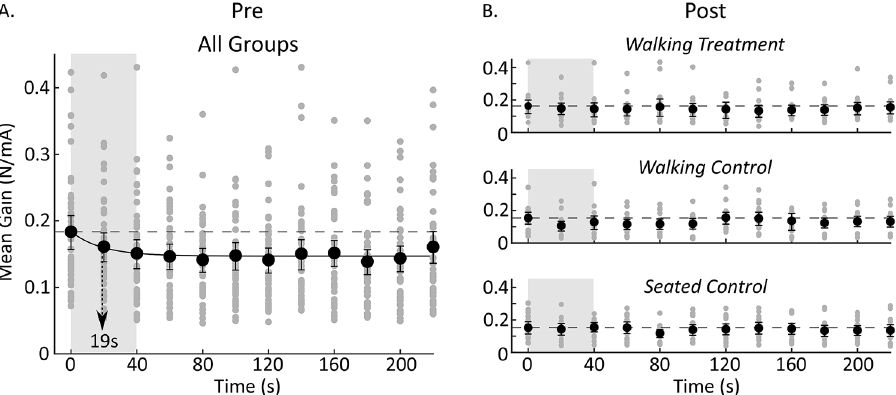
Figure 3. Changes in mean gain over time in both the pre and post-standing periods calculated using twenty seconds of data every 20 s over the 4-min trial. ( A ) Mean gain for the pre-standing period aggregated across all groups (because each condition was similar at this point). Mean gain decreased following a decaying exponential with a time constant of 19 s (n = 45). Arrow indicates the exponential’s time constant. ( B ) Mean gains for the post-standing periods. There were no apparent decreases in mean gain over time in the post-standing period of any of the conditions. Segmented horizontal line serves as a reference indicating the amplitude of the first time point. Error bars are 95% confidence intervals for the mean.